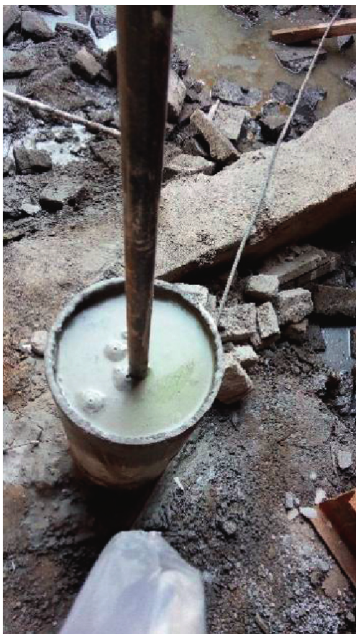
Figure 6: Underpinning pile after grouting.